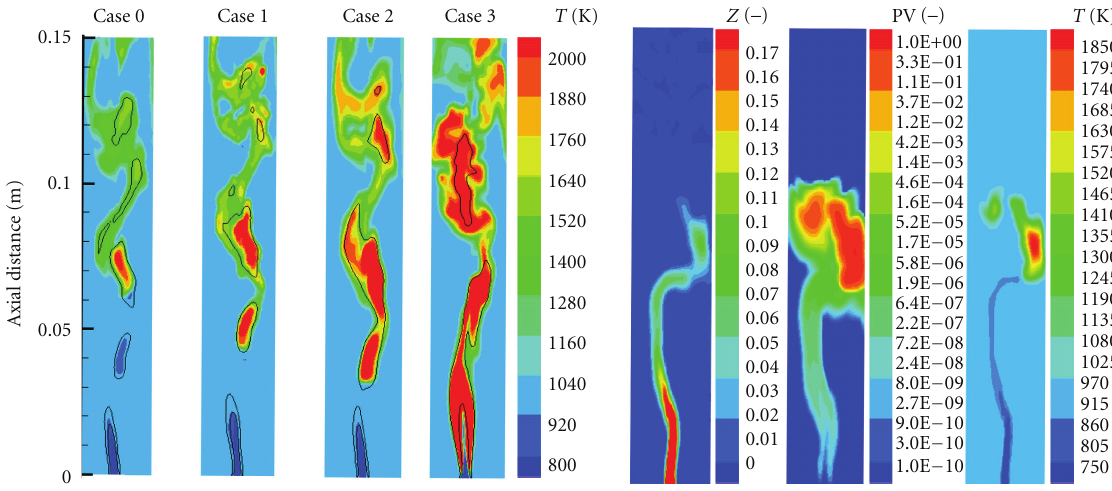
Figure 7: (a): Snapshot of temperature. (Lines: stoichiometric (Z st = 0 . 17) and most reactive (Z MR = 0 . 025) mixture fraction). (b): the mixture fraction ( Z ), the normalized progress variable (PV), and the temperature ( T ) for Case 0.